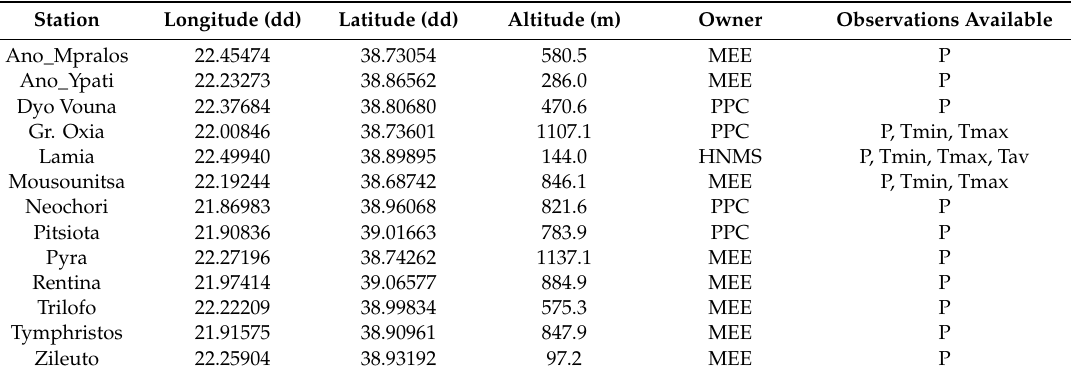
Table 2. Meteorological stations used in estimation of E-OBS e ffi